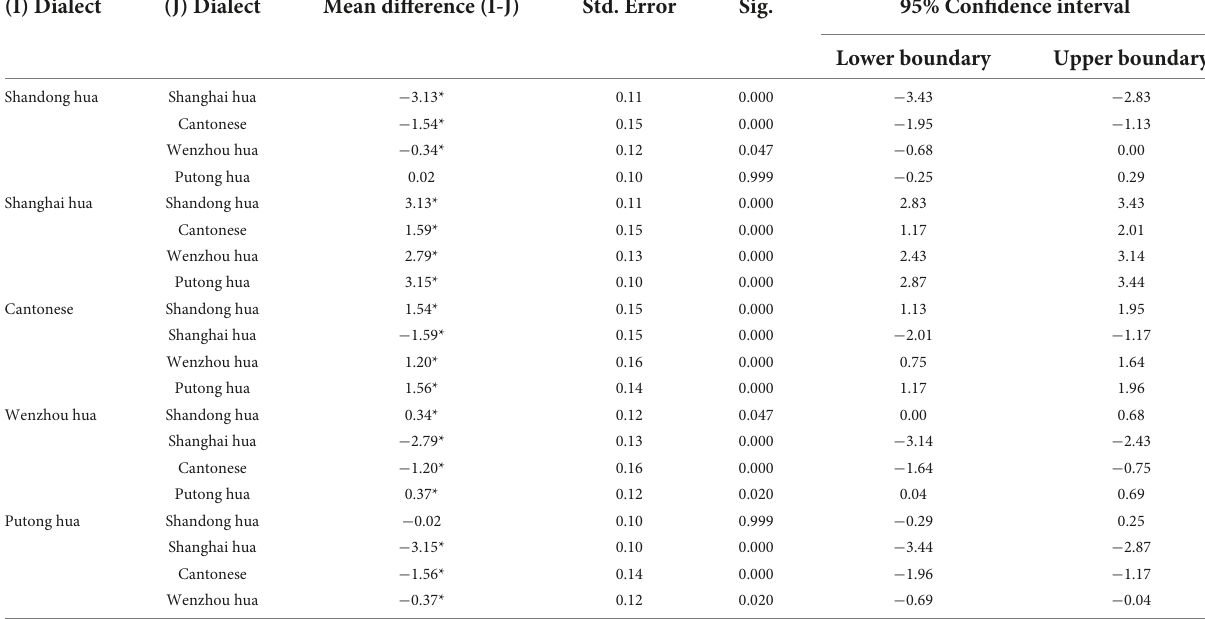
TABLE 4 Comparative English proficiency.